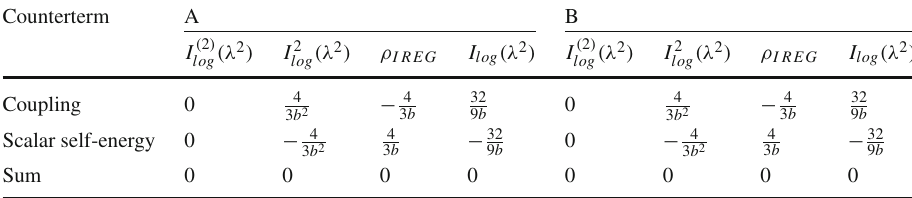
Table 3 Results for scalar QED using CDR and DRED, where ρ = γ − ln 4 π + ln ( p 2 /μ 2 E